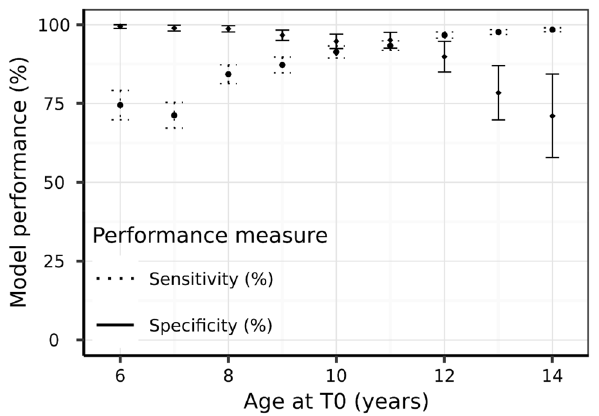
Figure 4. Model sensitivity and specificity with 95% confidence intervals as a function of age at evaluation.